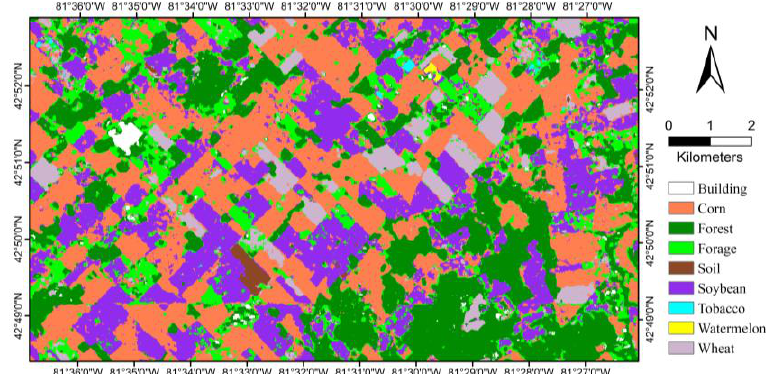
Figure 6. The classification map using CP-RF method with all 11 RADARSAT-2 images.